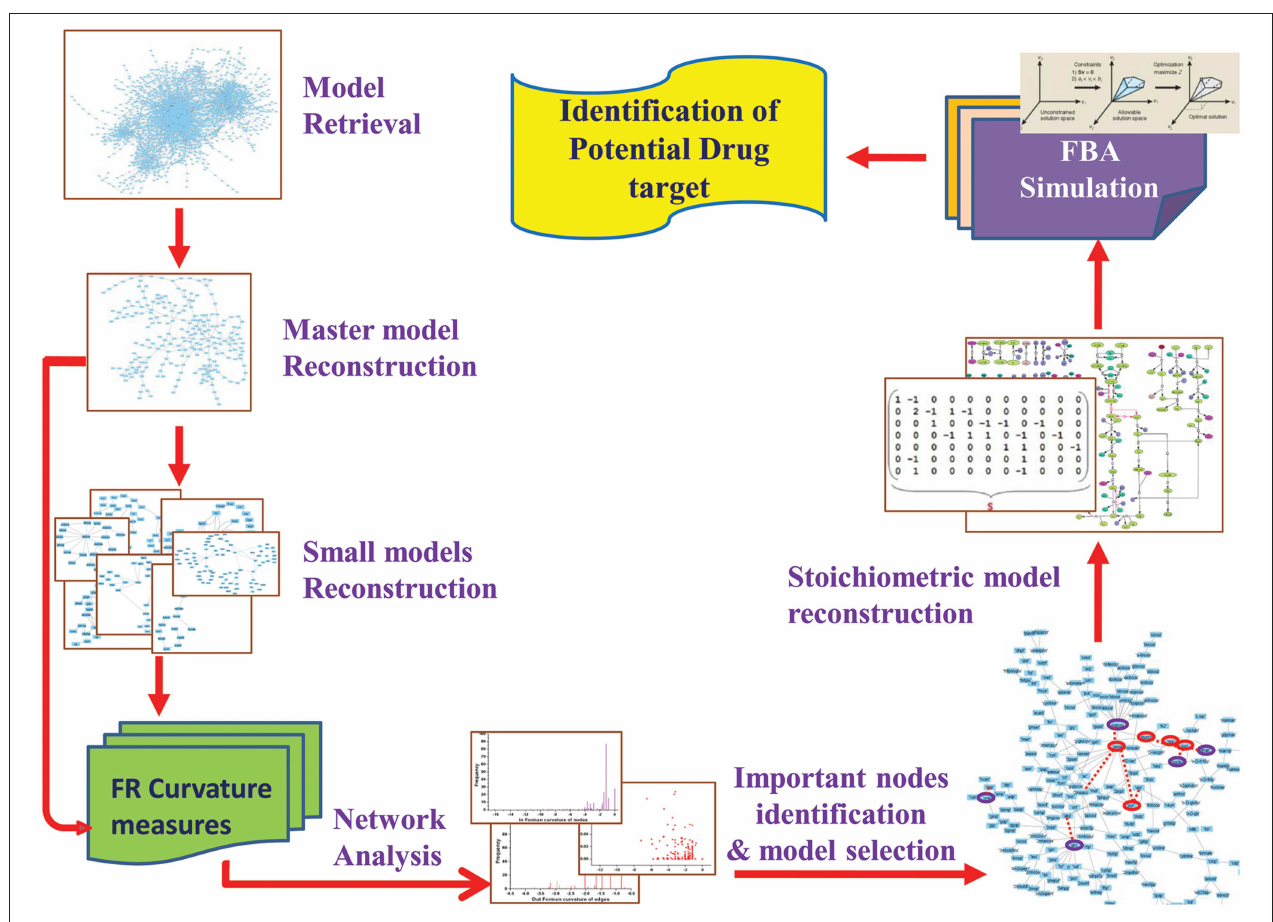
FIGURE 2 | Overview of the workflow strategy